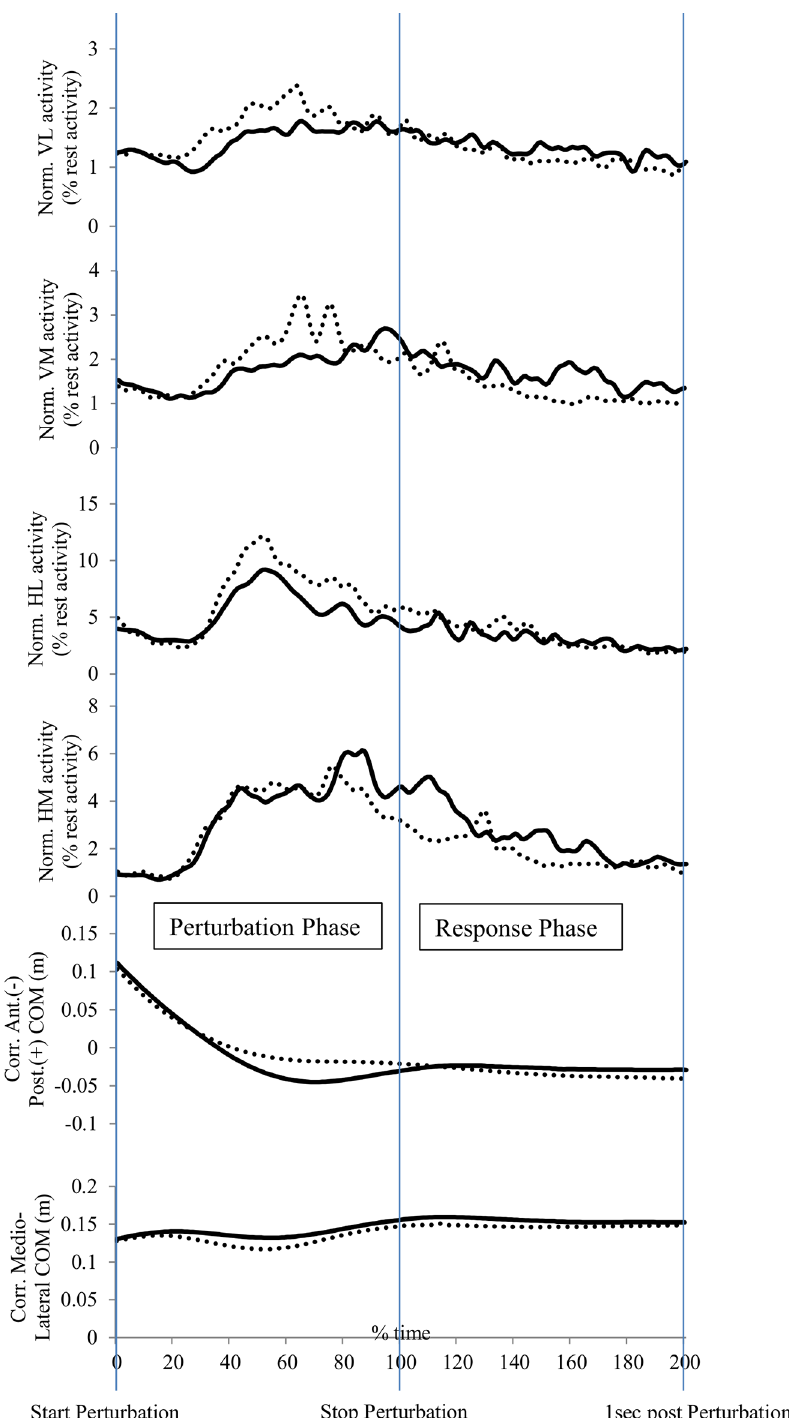
Fig 2. Data of all 13 participants to illustrate the different time periods. The straight line represents the average data for the large multi-planar perturbation (MMP-L) and the dotted line represents the average data for the large single-planar perturbation